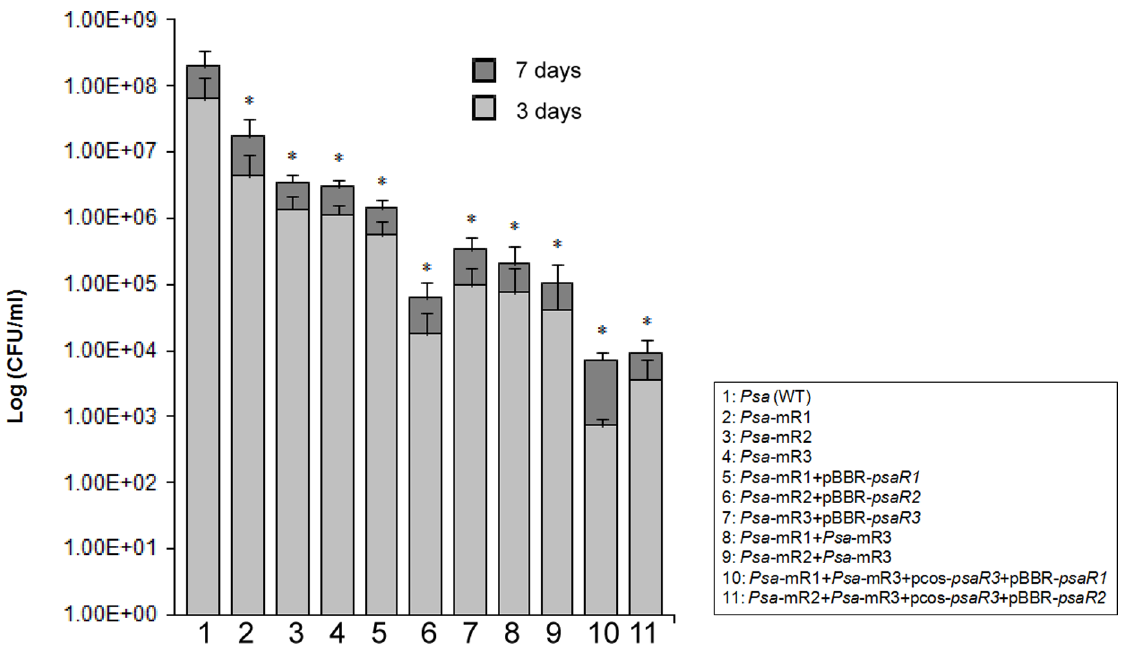
Figure 4. Inplanta survival of Pseudomonassyringae pv. actinidiae strains in Actinidiadeliciosa cv Hayward leaf. Histogram reporting in planta survival of Psa strains: The average bacterial count (log cfu/ml) of three independent experiments is reported with standard deviations for 3 rd and 7 th day after bacterial inoculation (1–2 6 10 6 cfu/ml) in Actinidia deliciosa cv. Hayward leaf. Statistical significance with respect to Psa wild type is indicated with one asterisk ( P , 0.01).